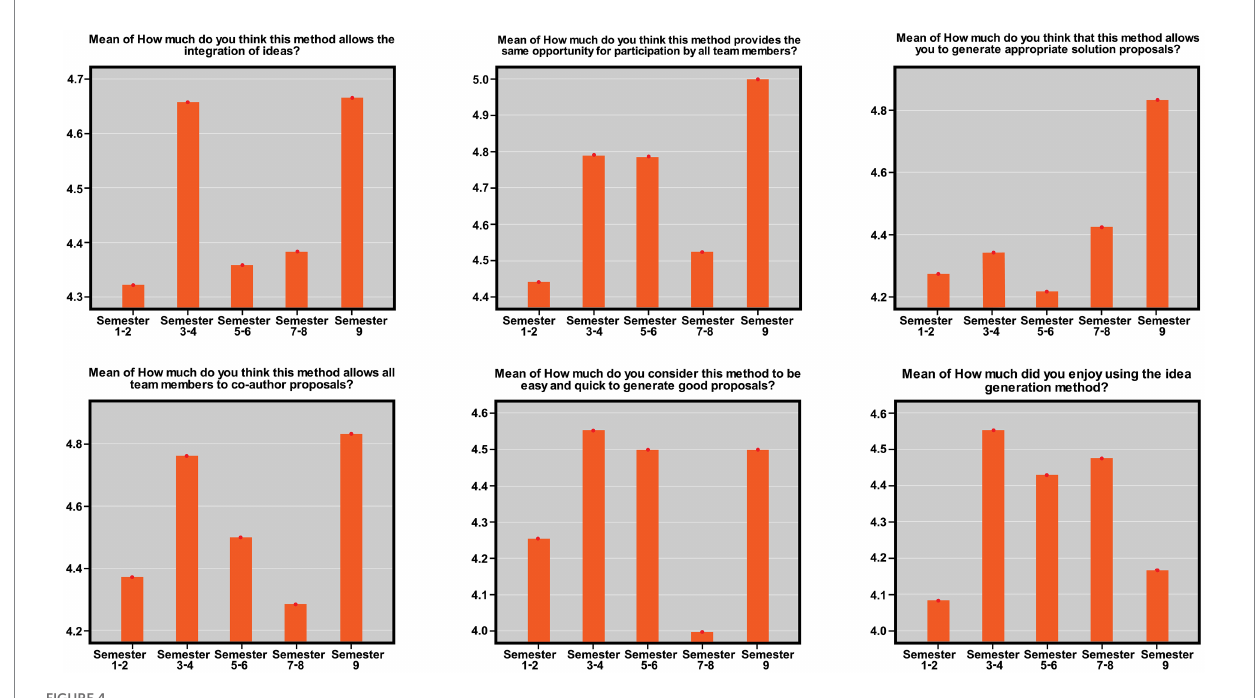
FIGURE 4 Plots of means for semesters and perception-experience